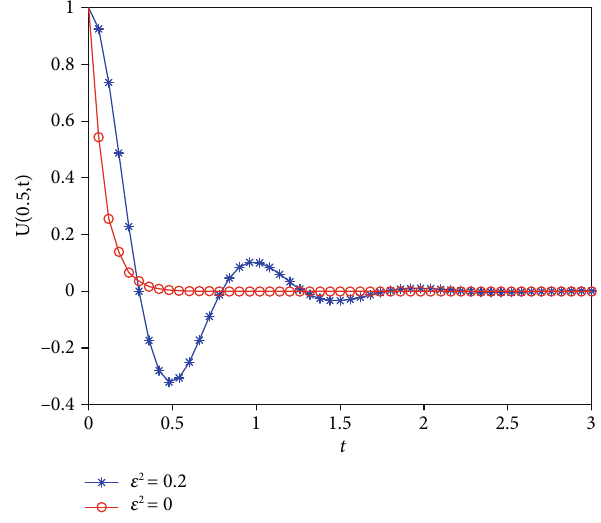
Figure 6: Temperature distribution images at x = 0 : 5